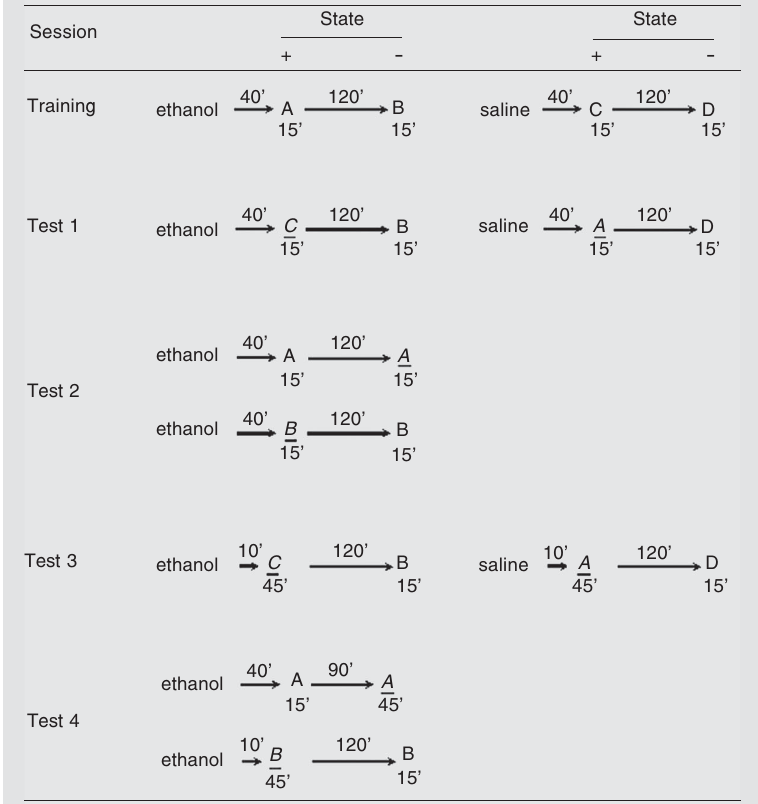
Table 1. Experimental design of the training and test session